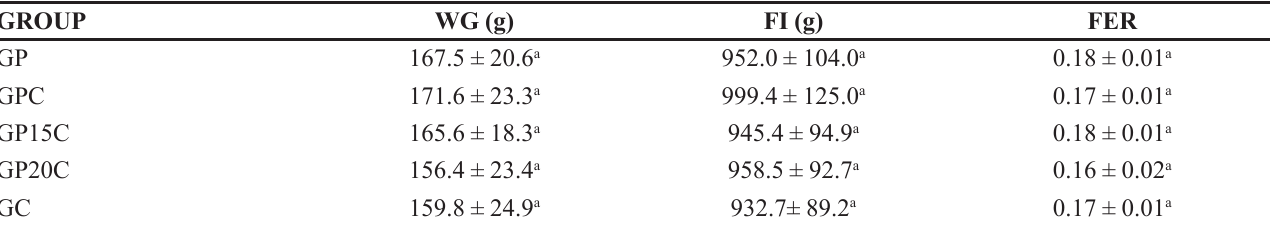
GP - diet with bread; GPC - diet with bread and cholesterol; GP15C - diet with 15% quinoa bread and cholesterol; GP20C - diet with 20% quinoa bread and cholesterol; GC - diet with cholesterol. Values in the same column with different letters indicate a statistically significant difference between the means by the Tukey test (p ≤ 0.05). (n=6) TABLE VI - Means and standard deviations of levels of aspartate aminotransferase (AST) and weight and fat content of liver of adult mice, with and without supplementation of their diet with bread and cholesterol for 42 days GROUP